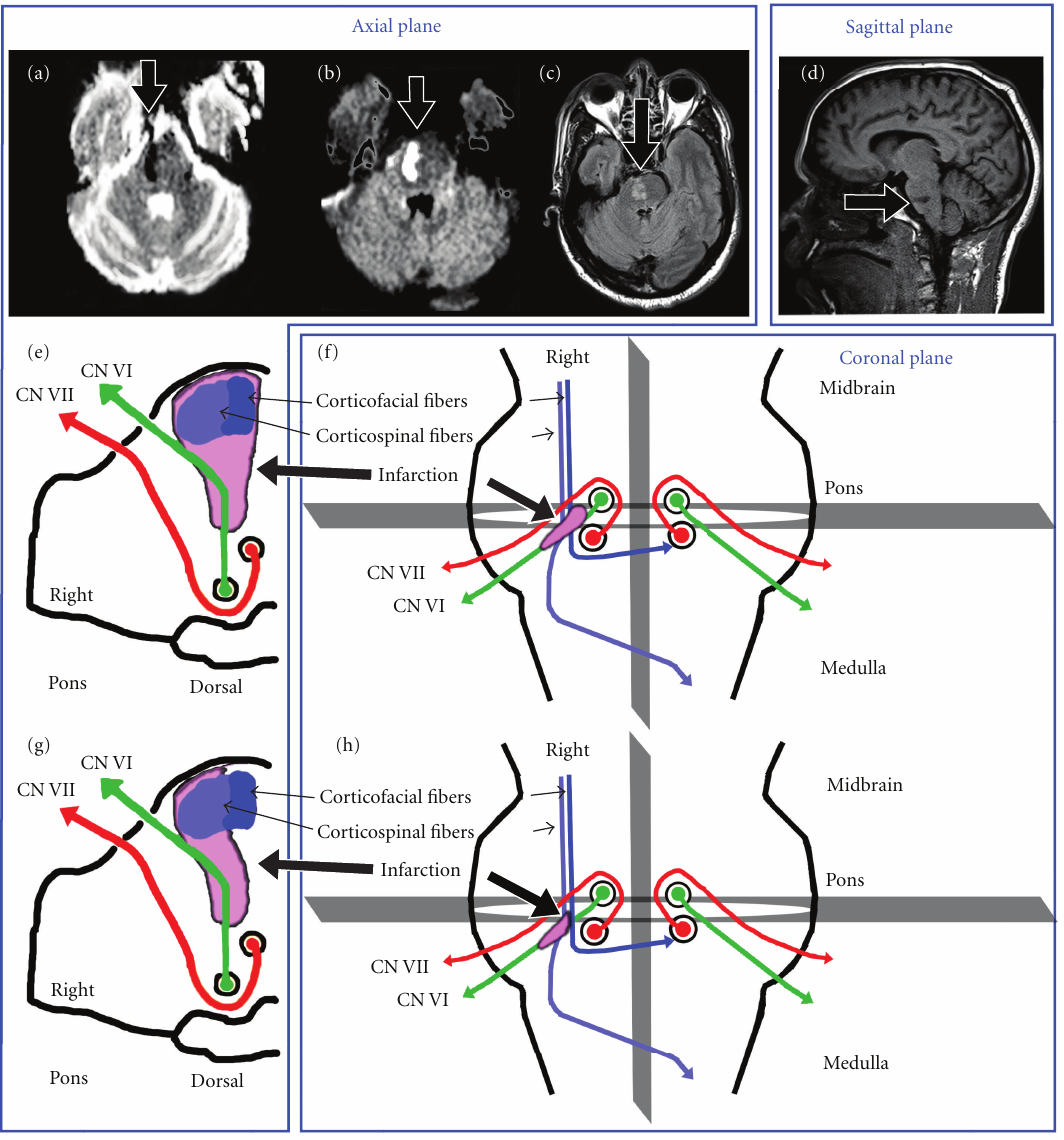
Figure 1: Brain MRI (3-Tesla) shows the axial apparent di ff usion coe ffi cient (a), di ff usion weighted (b), fluid-attenuated inversion recovery (c), and sagittal T1 weighted (d) images. The schematic figures of the axial and coronal planes depict the classic ((e) and (f)) and common ((g) and (h)) types of Raymond